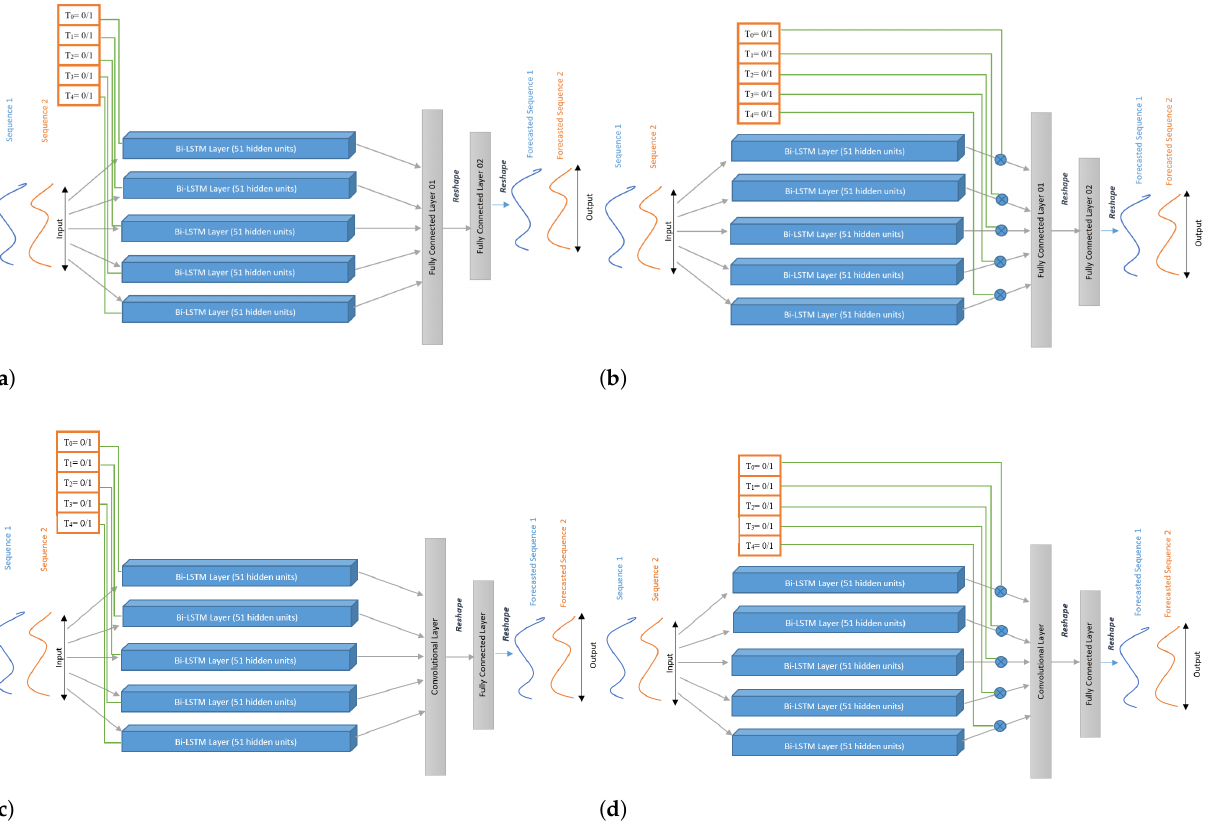
Figure 7. Multi-task learning architectures with Bi-LSTM sub-models; ( a ) Model 4: processing MTD internally in each sub-model; ( b ) Model 5: incorporating MTD through a gating mechanism; ( c ) Model 6: processing MTD internally in each sub-model using the Conv layer; ( d ) Model 7: incorporating MTD through a gating mechanism using the Conv